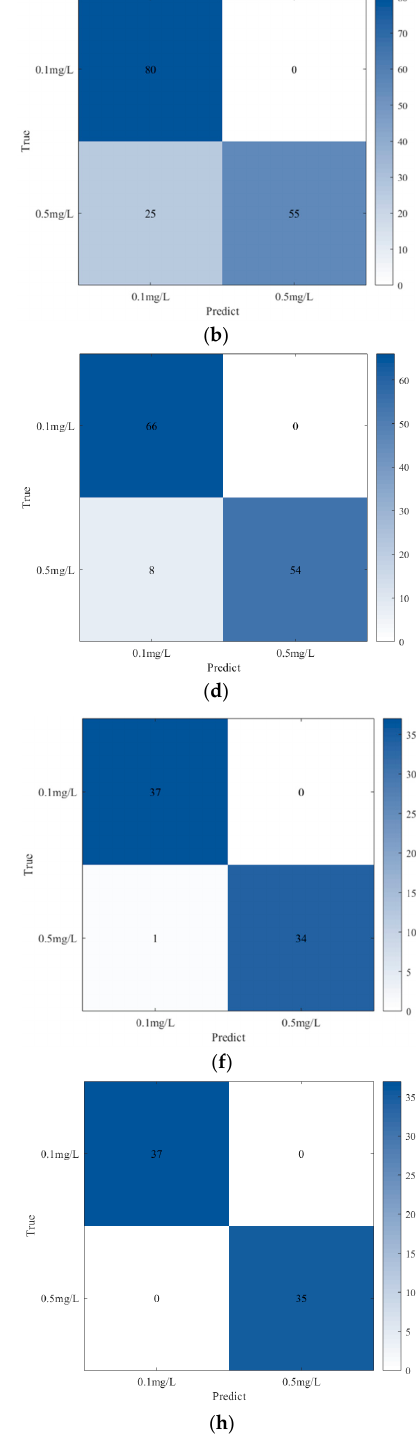
Figure 4. ( a ) Single temperature model training set confusion matrix; ( b ) single temperature model test set confusion matrix; ( c ) ( − 20 ± 2) °C and (20 ± 2) °C mixed temperature correction model training set confusion matrix; ( d ) ( − 20 ± 2) °C and (20 ± 2) °C mixed temperature correction model test set confusion matrix; ( e ) ( − 20 ± 2) °C, ( − 10 ± 2) °C, and (20 ± 2) °C mixed temperature correction model training set confusion matrix; ( f ) ( − 20 ± 2) °C, ( − 10 ± 2) °C, and (20 ± 2) °C mixed temperature correction model test set confusion matrix; ( g ) ICA correction model training set confusion matrix; ( h ) ICA correction model test set confusion matrix.